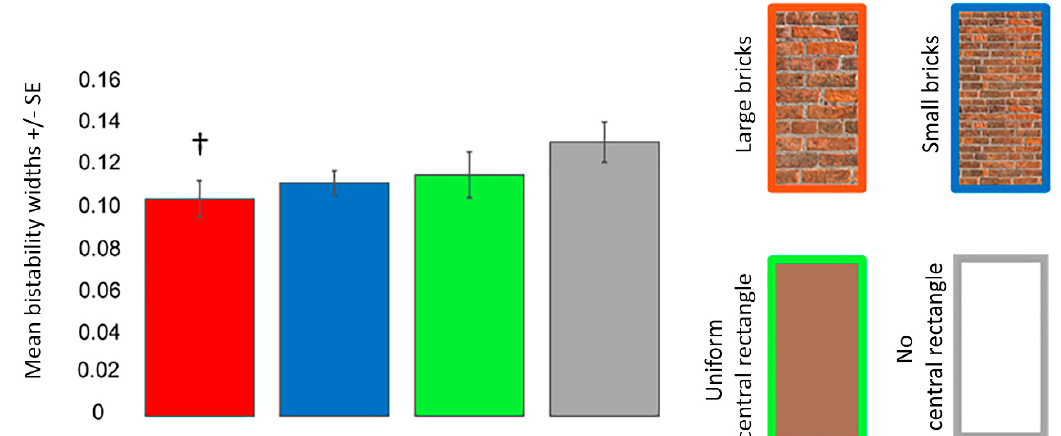
Figure 8. Mean bistability widths for the different Poggendorff stimuli in experiment 2. The dagger (†) denotes a difference from the no central rectangle condition at p < 0.050 after correcting for multiple comparisons using the Bonferroni method. Mean bistability widths were computed by subtracting P = 0.25 from P = 0.75. Error bars denote standard errors for within-subject contrasts as described by O’Brien and Cousineau [22].